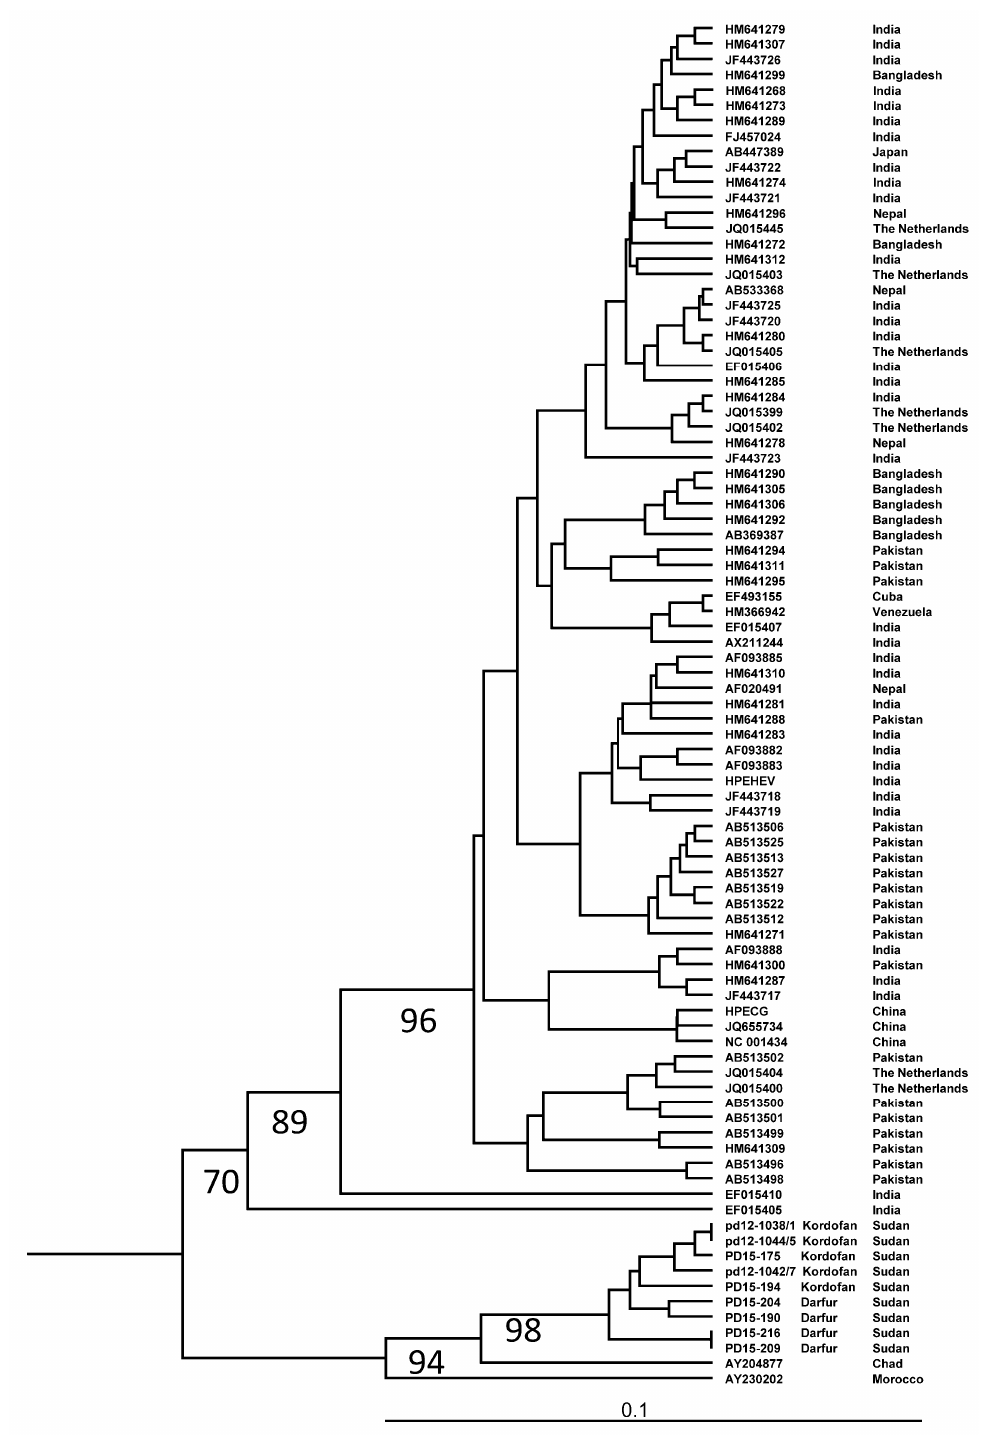
Figure 2. Branch of 89 genotype 1 strains in a phylogenetic tree based on 368 nucleotides of partial polymerases in the open reading frame (ORF) 1 region. Boot strap values obtained from 1000 replicates are given at the branches. The accession numbers and origins of the strains are given at the